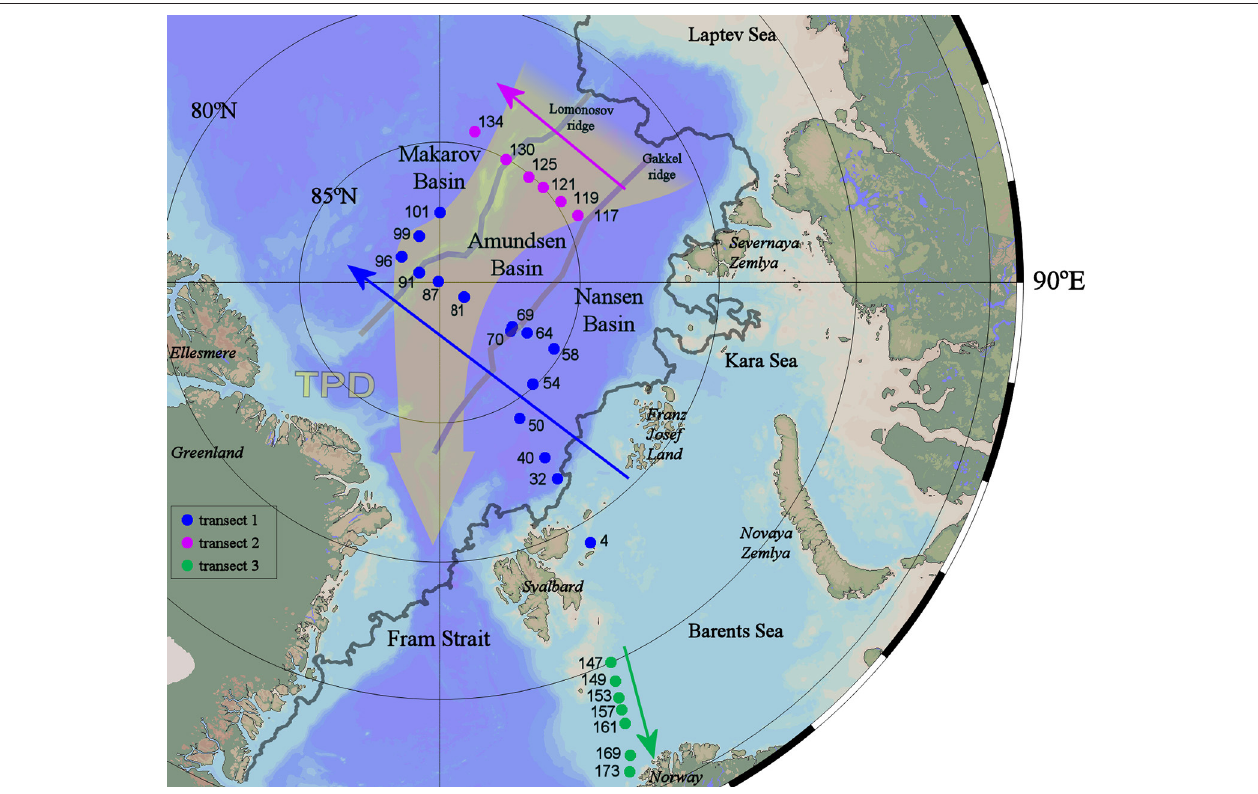
FIGURE 1 | Station map of the ultraclean casts sampled during the TransARC II cruise (PS94) on the German icebreaker RV Polarstern in the summer of 2015.The direction of the Transpolar Drift is indicated with the broad gray-yellow arrow (Slagter et al., 2017). Stations numbers are given in three transects, 1–3, the arrows give the direction in which transects are presented in Figures 2 , 5 – 9 . The gray line indicates the sea ice edge at the time of sampling station 32 (23 August 2015, NSIDC database, 2015). Map and all section plots following were generated using Ocean Data View 4 (Schlitzer,